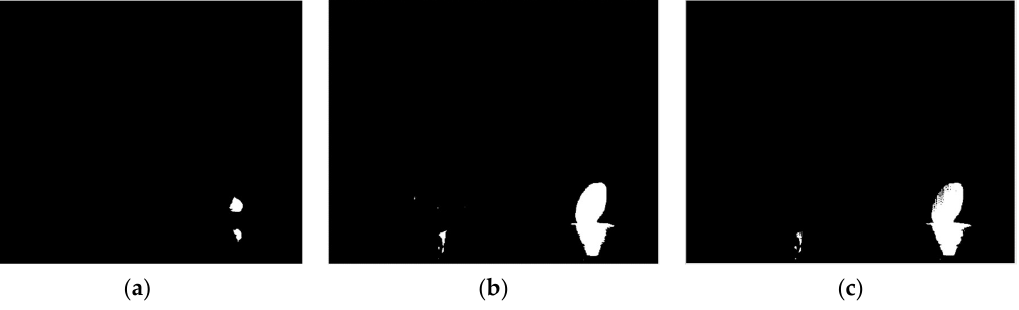
Figure 5. Simple segmentation based on grayscale thresholding: ( a ) 13 μs; ( b ) 665 μs; ( c ) 1330 μs. The histogram of an integral image is calculated as follows: The grayscales of input image I T are divided into equal intervals called HD, based on the gray level; there are a total of M intervals, where M is total number of gray levels. If the imaging system has D bits, then M is 2 D , and the number of pixels falling in each interval is calculated as N . Based on the medium gray level, the M intervals are divided into two parts. If the system bit width is 14 bits, the medium level is 8192. The two search intervals are [0, 8192] and (8192, 16383]. In the first search interval, the maximum value of the count N is calculated, and the gray value corresponding to the maximum value N is determined as the gray value G L in the ambient-temperature region of the frame. In the last search interval, the maximum value of the count N is calculated, and the gray value corresponding to the maximum value N is determined as the gray value G H in the high-temperature region of the frame, as